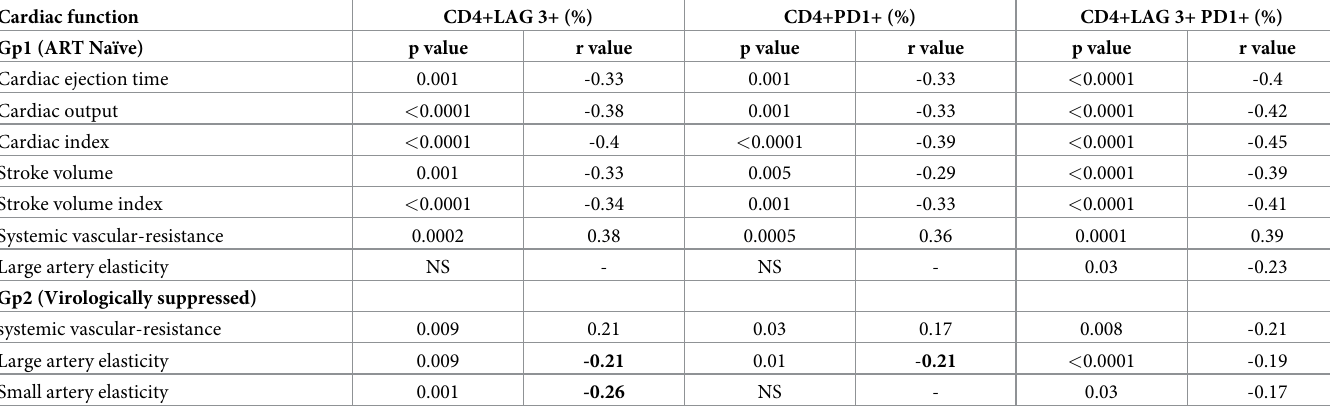
Table 2. Correlations between LAG-3, PD1 and LAG-3+PD1+ expressing CD4 T cells and cardiac function. Cardiac function